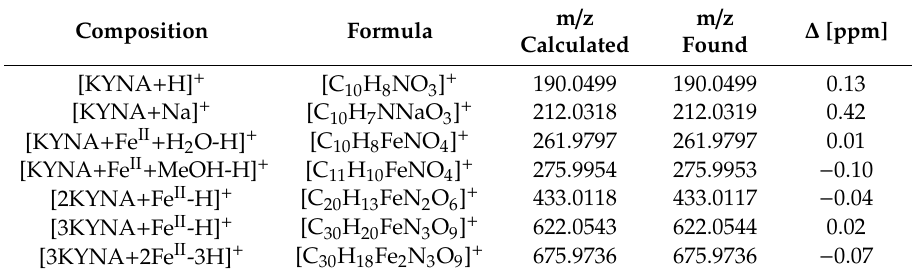
Table 1. The main signals of 56 Fe-KYNA coordination complexes in the solutions of KYNA with Fe II analyzed by nano-ESI-MS; a positive ionization mode.